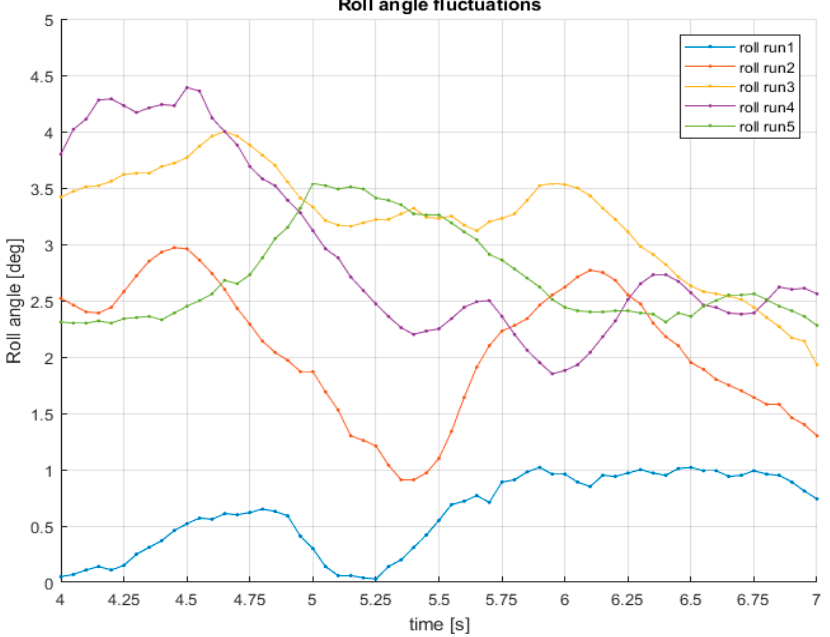
Figure 14. Roll angle fluctuations during 5 trials of the emulation of the motorcycle crash (id90–InSAFE).